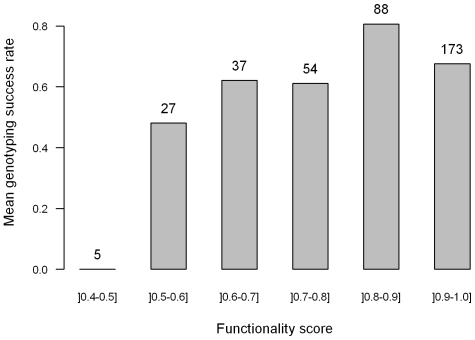
Genotyping success rate according to functionality score for the 384 SNPs of the assay.The number of SNPs in each functionality score class is indicated above each bar.